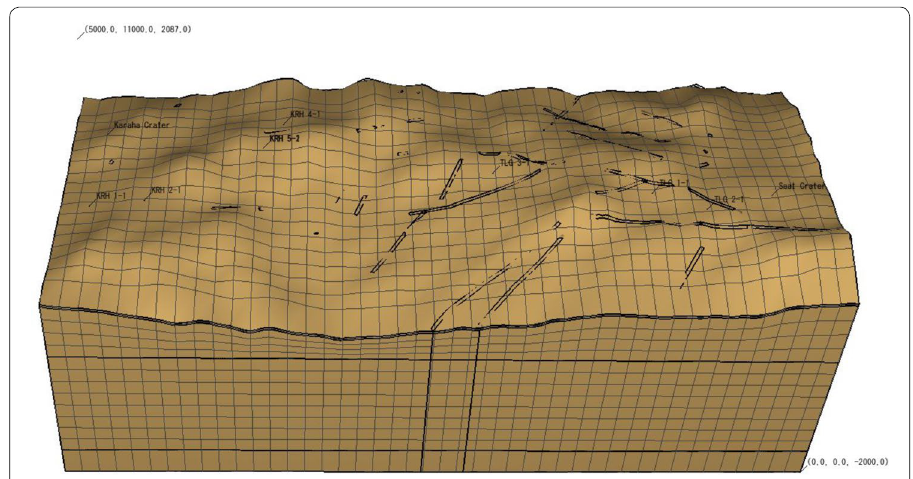
Fig. 6 3-D grid system model of Karaha–Talaga Bodas